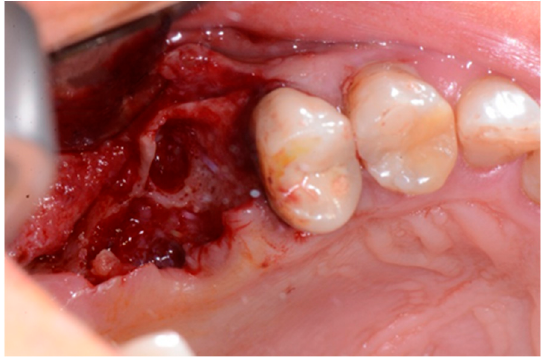
Figure 2. Clinical situation after crown removal.